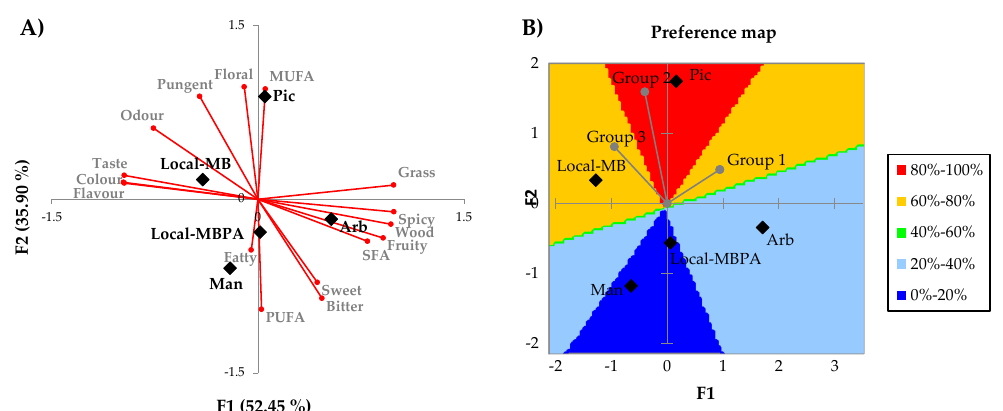
Figure 5. Attribute map ( A ) and external preference mapping and contour plot ( B ) of VOOs. Preference model Figure 1 and F2 of principal components analysis (PCA). Local-MBPA (60% Mansa and Brava, 25% Picual, and 15% Arbequina); Local-MB (60% Mansa and 40% Brava); Man (100% Mansa cultivar); Pic (100% Picual cultivar); Arb (100% Arbequina cultivar).